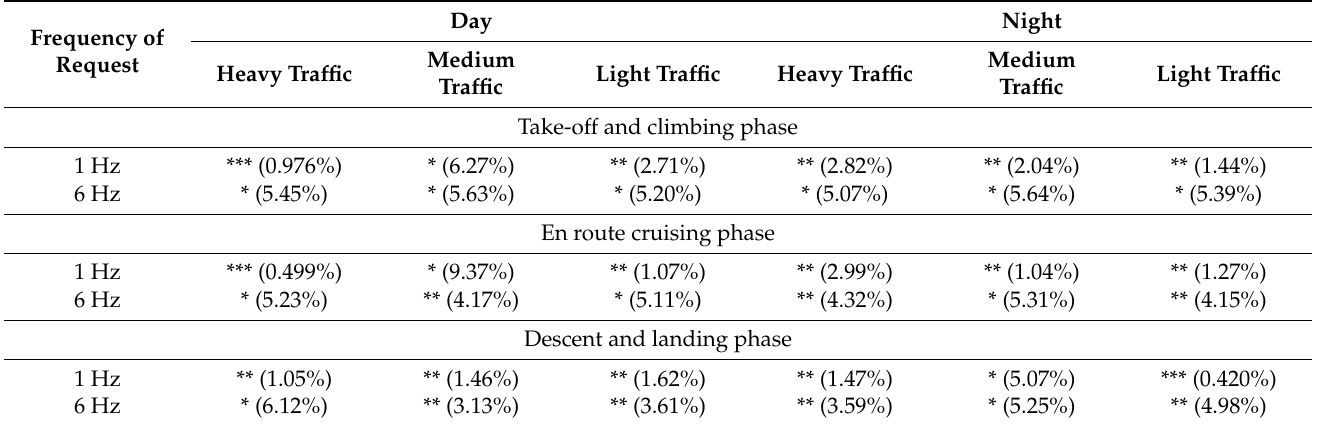
Table 5. Percentage of data loss resulted over the specified flight task period 1